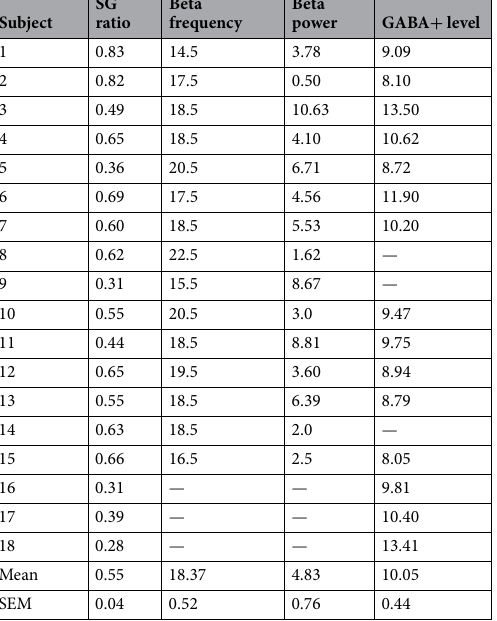
Table 1. SG ratio, GABA + level, and beta peak frequency and power in each subject. SG = sensory gating, SEM = standard error of the mean.